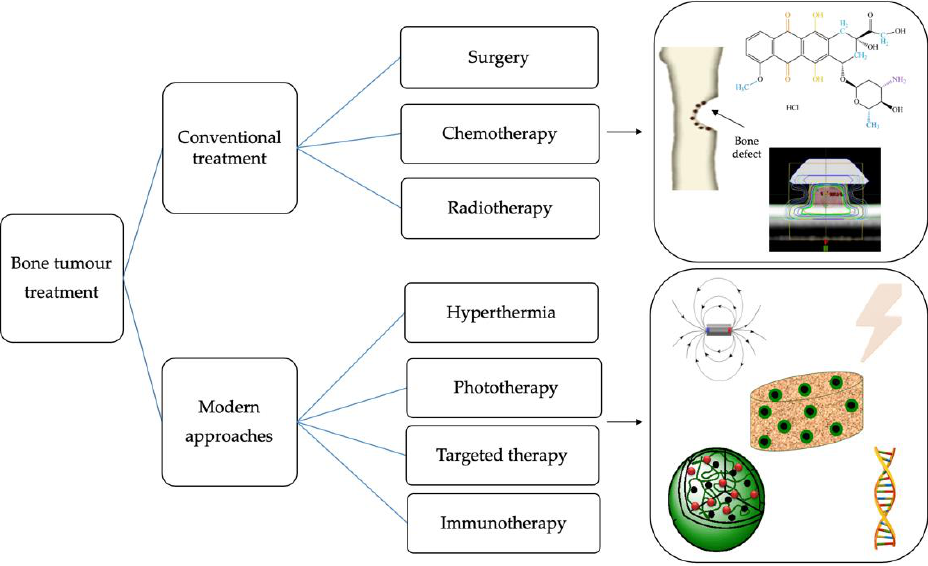
Figure 3. Strategies for bone tumors treatment.